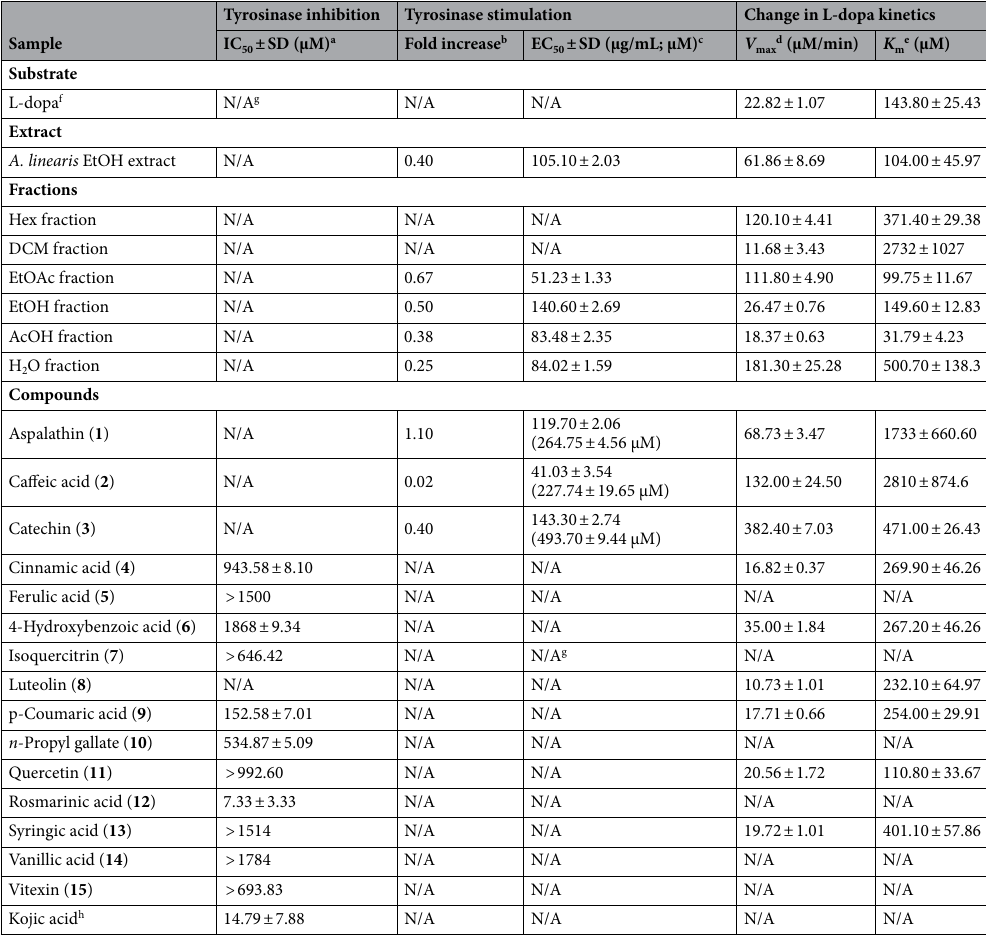
Table 2. Effect of the ethanolic extract, fractions and the phyto-constituents identified in Aspalathus linearis on tyrosinase rate. a Absolute IC 50 value, the concentration exhibiting 50% inhibition of the enzyme’s activity. b Determined as the enzyme rate of the sample divided by the enzyme rate of the vehicle control. c Relative EC 50 value, the concentration of the sample exhibiting 50% of its maximal response. d V max (maximum enzyme velocity). e K m (michaelis constant—concentration of the sample where the enzyme reaches half of its V max ). f Substrate. g Not applicable/none active. h Positive control.